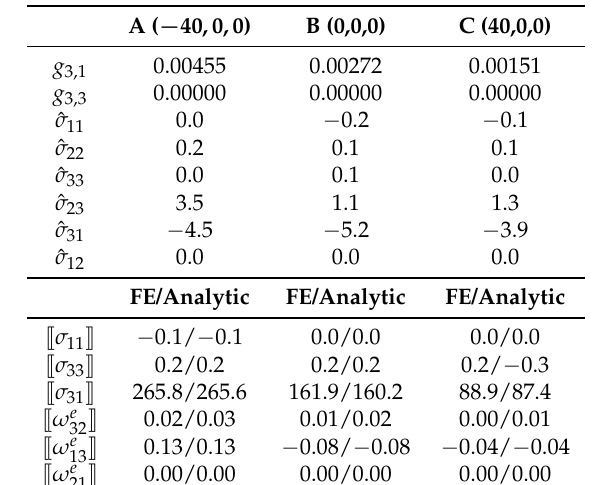
]] (MPa) and [[ ω e ]] ( ◦ ) given by the FE ∼ ∼